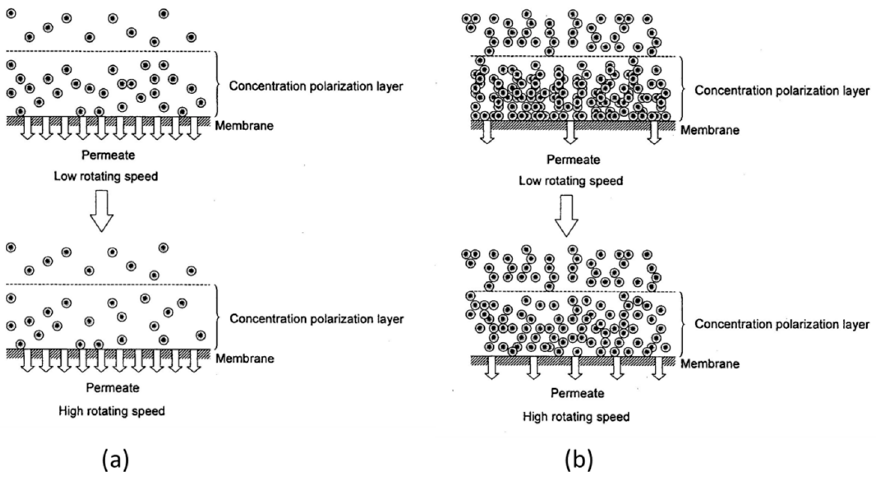
Figure 9. Schematics of concentration polarization layer of rotating membrane surface. ( a ) low concentration ( b ) high concentration.